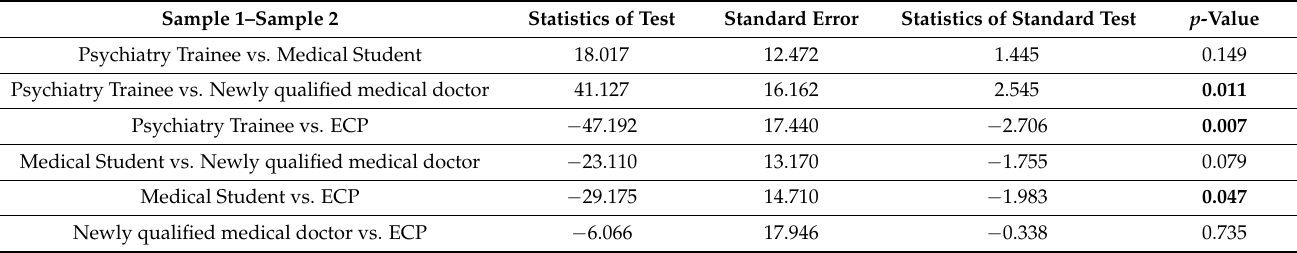
Table 3. Pairwise comparisons PSI according to the level of